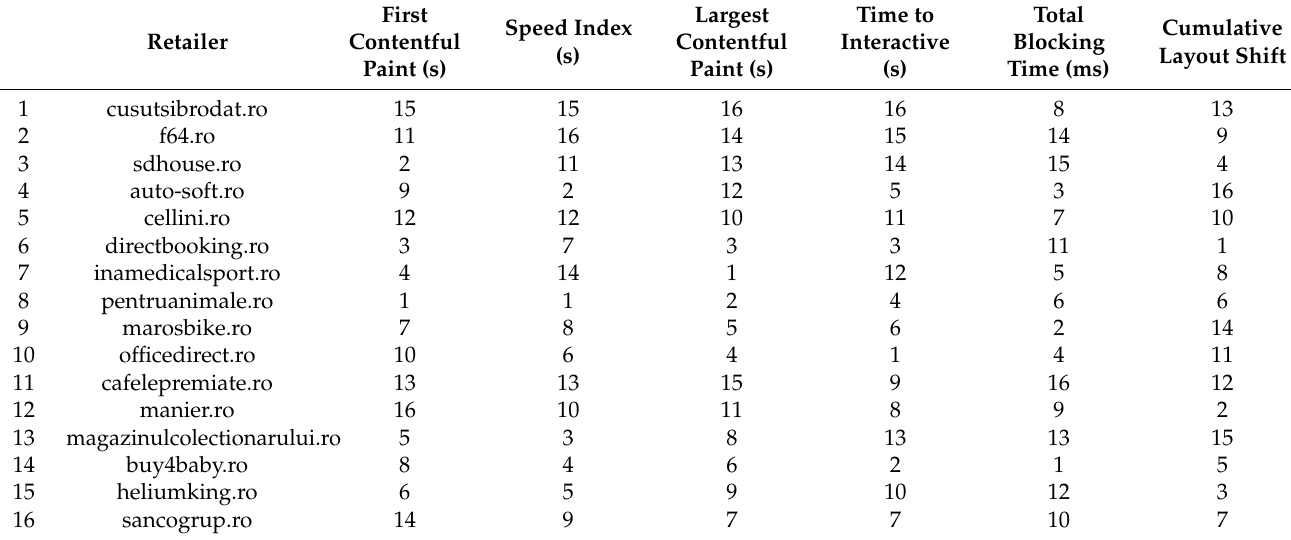
Table 3. The 1st place matrix for performance